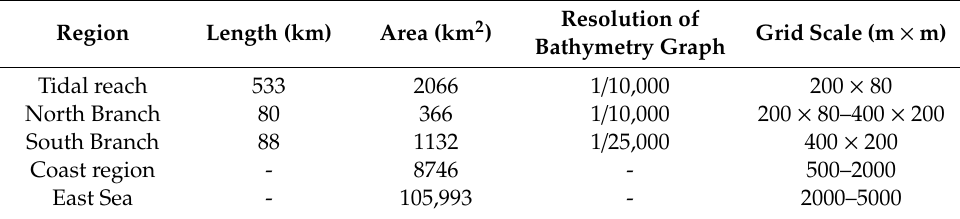
Table 1. Grid scales of high-resolution unstructured grids in Yangtze Estuary.